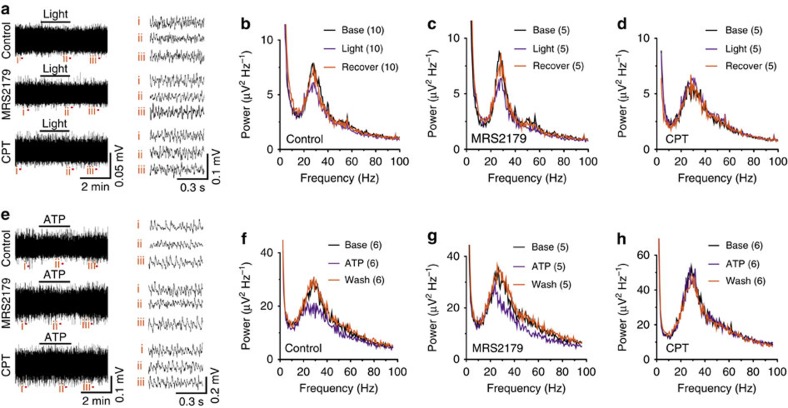
Astrocyte-derived ATP downregulates the power of kainic acid-induced ex vivo gamma oscillation in vitro.(a) Sample traces of kainic acid-induced ex vivo gamma oscillation before, during and after 2 min light stimulation (1 Hz, 0.5 s on and 0.5 s off) of astrocytes expressing ChR2 in control conditions (top), in the presence of 20 μM MRS2179 (middle), and in 1 μM CPT (bottom). (i), (ii) and (iii) indicate representative traces in each period. (b–d) Summary power spectra of kainate-induced gamma oscillation before (black), during (violet) and after (orange) light stimulation in control conditions, in the presence of 20 μM MRS2179, and in 1 μM CPT. (e) Sample traces of kainic acid-induced ex vivo gamma oscillation before, during and after application of 1 μM ATP in control conditions (top), in the presence of 20 μM MRS2179 (middle), and in 1 μM CPT (bottom). (i), (ii) and (iii) indicate representative traces in each period. (f–h) Summary power spectra of kainate-induced ex vivo gamma oscillation before (black), during (violet) and after (orange) application of 1 μM ATP in control conditions, in the presence of 20 μM MRS2179, and in 1 μM CPT.